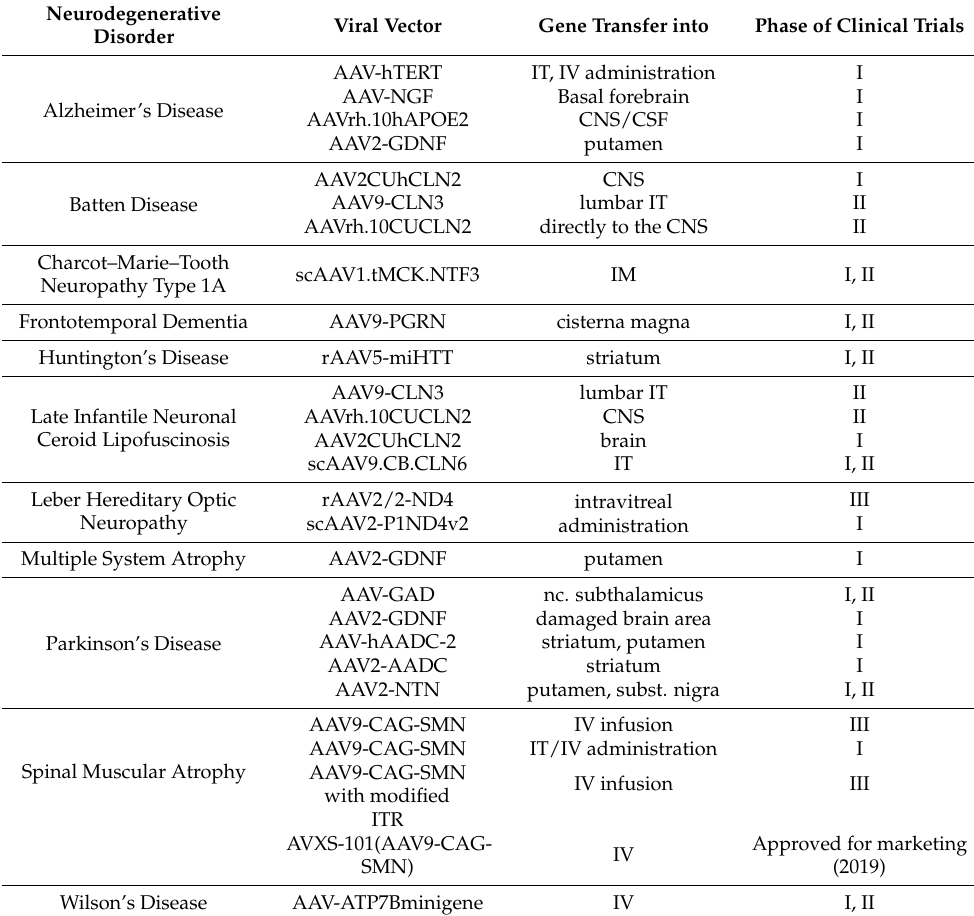
Table 1. Summary of clinical trials listed on website https://clinicaltrials.gov/ cited on 9 February 2021 focused on AAV mediated gene therapy in neurodegenerative